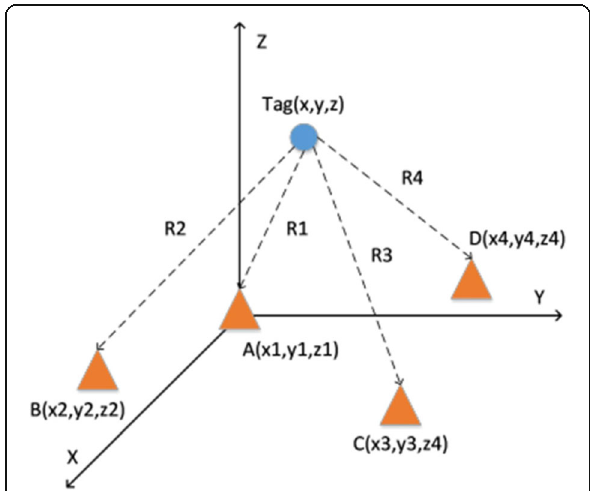
Fig. 5 3D positioning based on TDOA. Points A, B, C, and D are represented as four fixed base stations, the tag sends an ultra-wideband signal in a fixed time slot, and each base station intercepts this signal, calling the ranging algorithm to get the distance between base stations and the tags